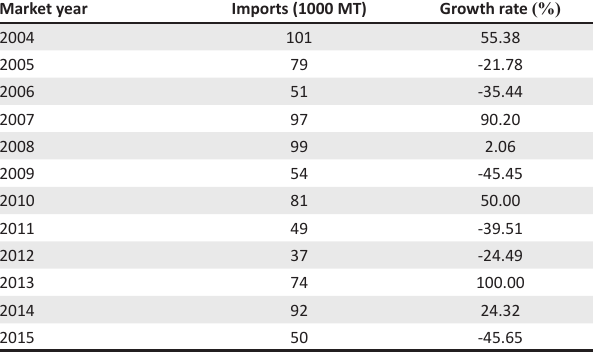
TABLE 2: Barley imports from 2004 to 2015.